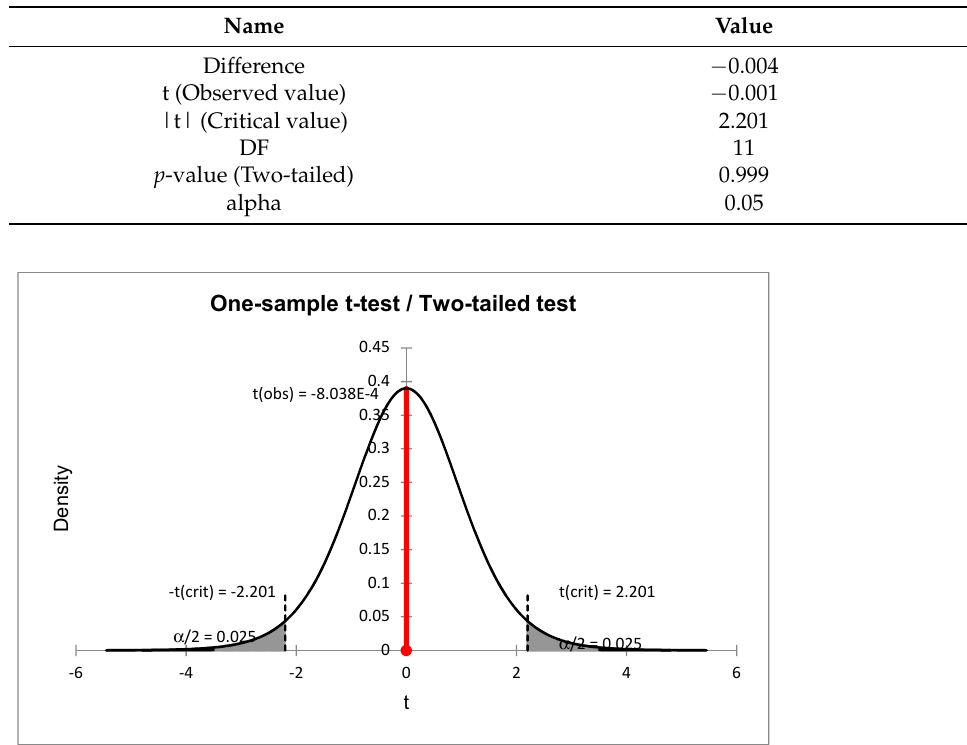
Figure 7. One-sample t-test/Two-tailed test for energy consumption during COVID-19.